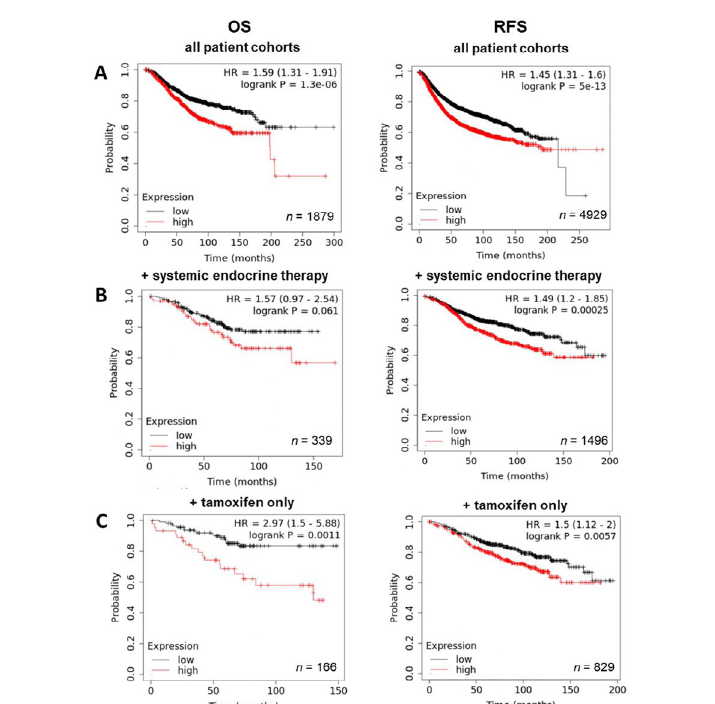
Figure 6. Kaplan-Meier plots describing ZIP4 mRNA expression relationship with OS and RFS, in breast cancer patients. All plots were generated using KmPlot [20] with expression cohorts defined by “auto-selected” cut-offs. Probe sets were optimized via “JetSet” function. Patient cohorts were progressively focused, initially to “include” those non-specific systemic endocrine therapy (B), before isolating those specifically treated with “tamoxifen only” (C). Hazard ratios (HRs) and significance values ( P ) are indicated on graphs, with the number of patients included in each analysis ( n )